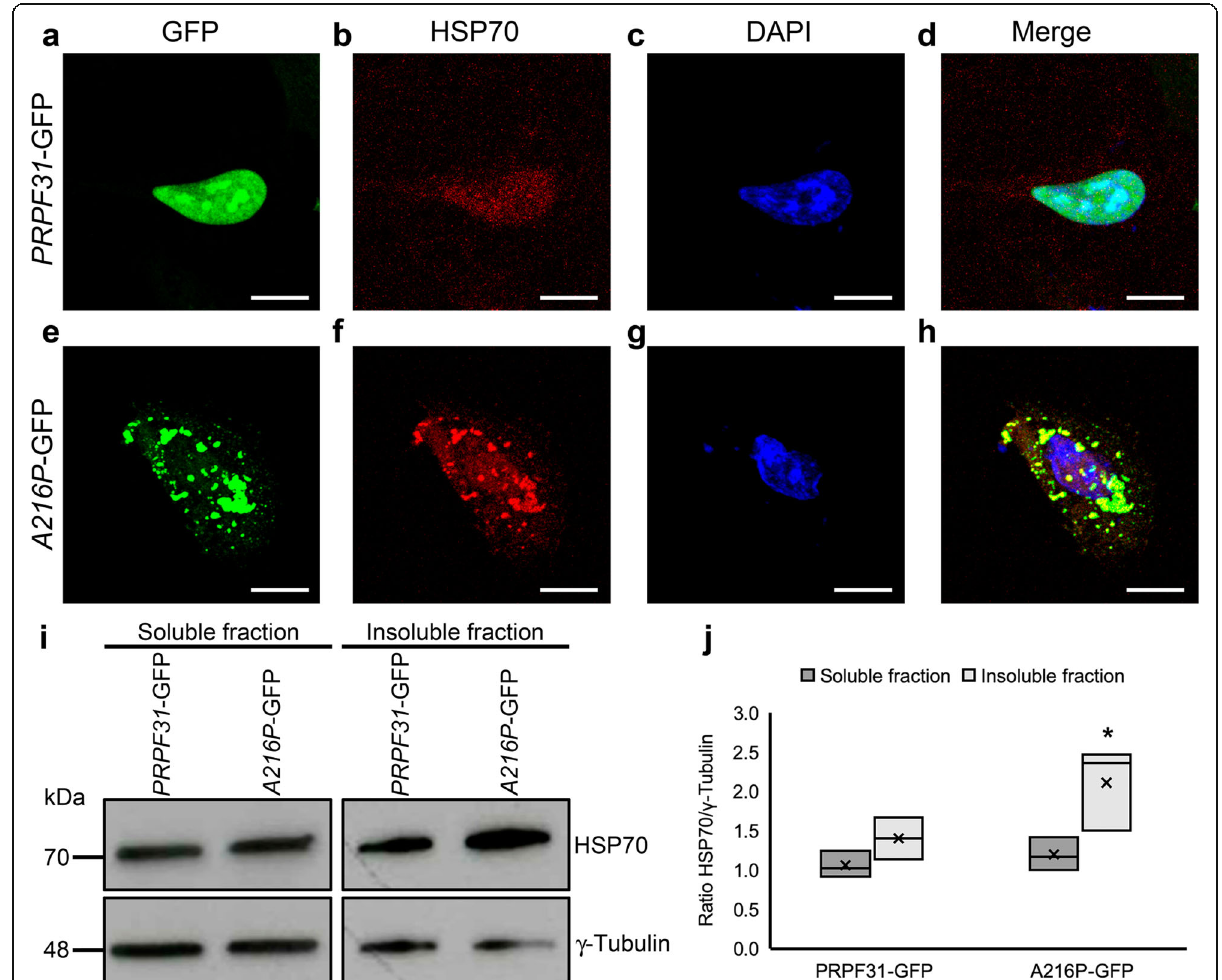
Fig. 7 Overexpression of A216P-GFP induces HSP70 activation in ARPE-19 cells. Immunostaining of cultured ARPE-19 cells transfected with PRPF31 -GFP ( a - d ) or A216P -GFP ( e - h ) displays PRPF31 aggregation in the cytoplasm of the cells overexpressing A216P -GFP (green) and colocalization of HSP70 (red) in the aggregates ( e - h ). Images correspond to a maximum projection of a Z-stack. Western blot analysis ( i ) and densitometry quantification ( j ) of the soluble and insoluble fraction of the transfected cells showing an increment of HSP70 concentration in the detergent-insoluble fraction of the cells transfected with A216P -GFP. Anti- γ -tubulin antibody was used as loading control ( i ). The boxplot j represents the ratio HSP70/ γ -tubulin in soluble and insoluble fraction of PRPF31 -GFP and A216P -GFP transfected ARPE-19 cells ( n = 3 in each group). Statistically significant differences were determined by Mann-Whitney U -test (* p < 0.05). Scale bars represent 10 μ